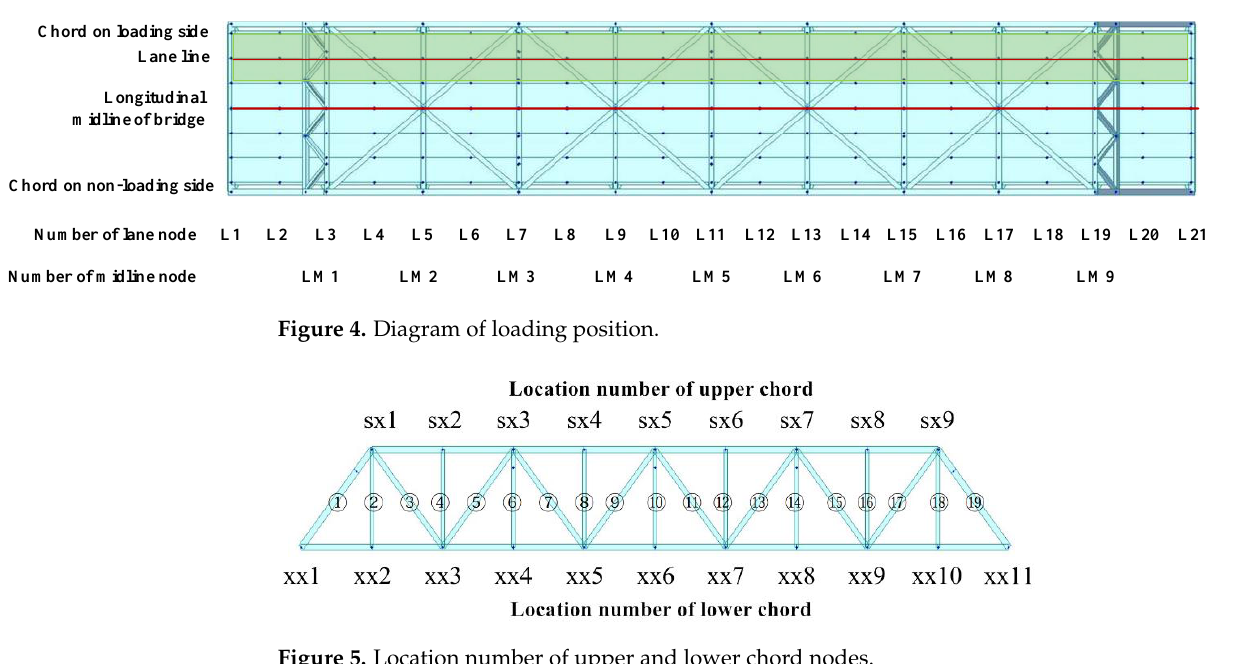
Figure 5. Location number of upper and lower chord nodes.